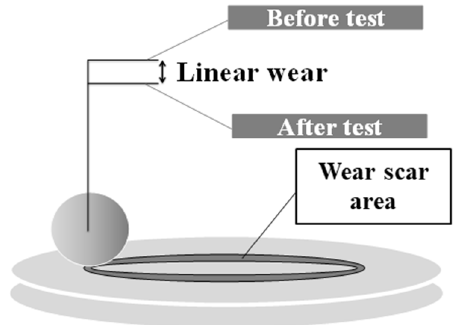
Figure 1. Linear wear and wear scar area registered to analyze the role of lubricants in the formation of an antiwear film.